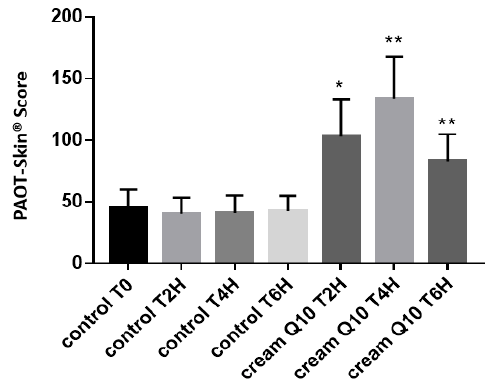
Figure 5. Effect of topical application of enriched ( n = 12) or not-CoQ 10 ( n = 12) creams on the PAOT-Skin Score ® according to time (Group III). * p < 0.0001; ** p < 0.003.